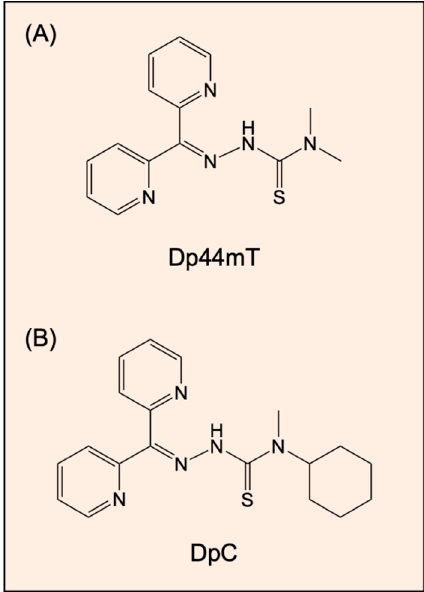
Figure 4. Line drawings of the structures of thiosemicarbazones: ( A ) di-2-pyridylketone 4,4-dimethyl-3-thiosemicarbazone (Dp44mT) and ( B ) di-2-pyridylketone-4-cyclohexyl-4-methyl-3-thiosemicarbazone (DpC). Both agents exert potent and selective anti-cancer activity in a wide variety of cancer models in vitro and in vivo [138–142] via a variety of molecular mechanisms